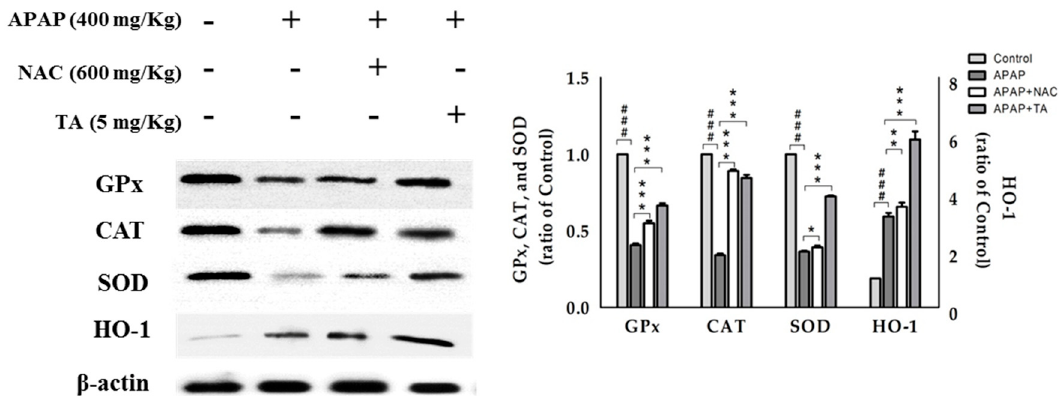
Figure 6. TA inhibited GPx, CAT, SOD, and HO-1 protein expression in APAP-induced mice. β -actin served as a loading control. The values are reported as the means ± S.E.M. of five mice per group. ### p < 0.01 compared with the control group; * p < 0.05, ** p < 0.01, and *** p < 0.001 compared with the APAP group.